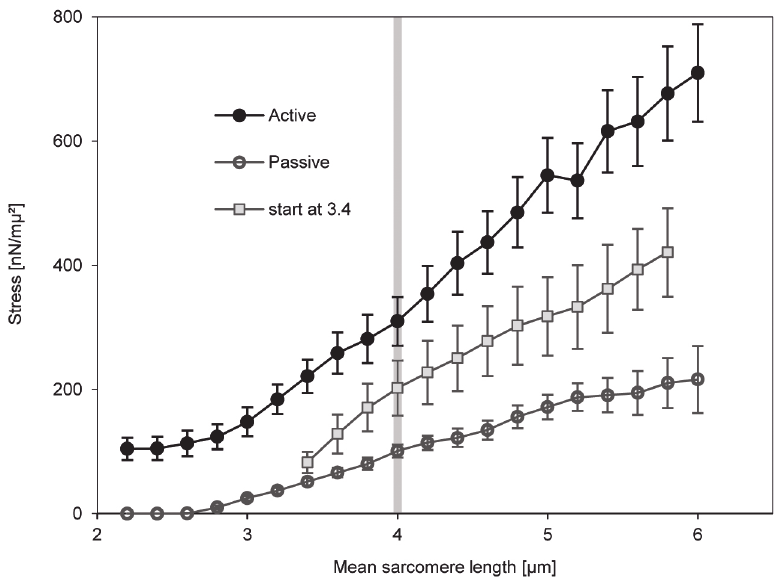
Fig 1. Mean ± standard deviation of stress versus average sarcomere length of myofibrils. Myofibrils were stretched in a low-calcium solution (passive stretch, open circles) and high-calcium solution from an initial sarcomere length of 2.4 μ m (active stretch, black circles) and 3.4 μ m (active stretch from 3.4 μ m/ sarcomere, grey squares). Based on the cross-bridge model, forces beyond actin-myosin filament overlap (sarcomere length > 4 μ m; grey vertical bar) in actively stretched myofibrils are predicted to coincide with forces in passively stretched myofibrils. However, forces in actively compared to passively stretched myofibrils are three to four times higher when the stretch starts at an initial sarcomere length of 2.4 μ m, and around twice as high when the stretch starts at an initial sarcomere length of 3.4 μ m. Careful experimental and theoretical testing and analysis of all individual sarcomere lengths revealed that these results cannot be explained by the development sarcomere length non-uniformities. A detailed description of the experiments is given elsewhere